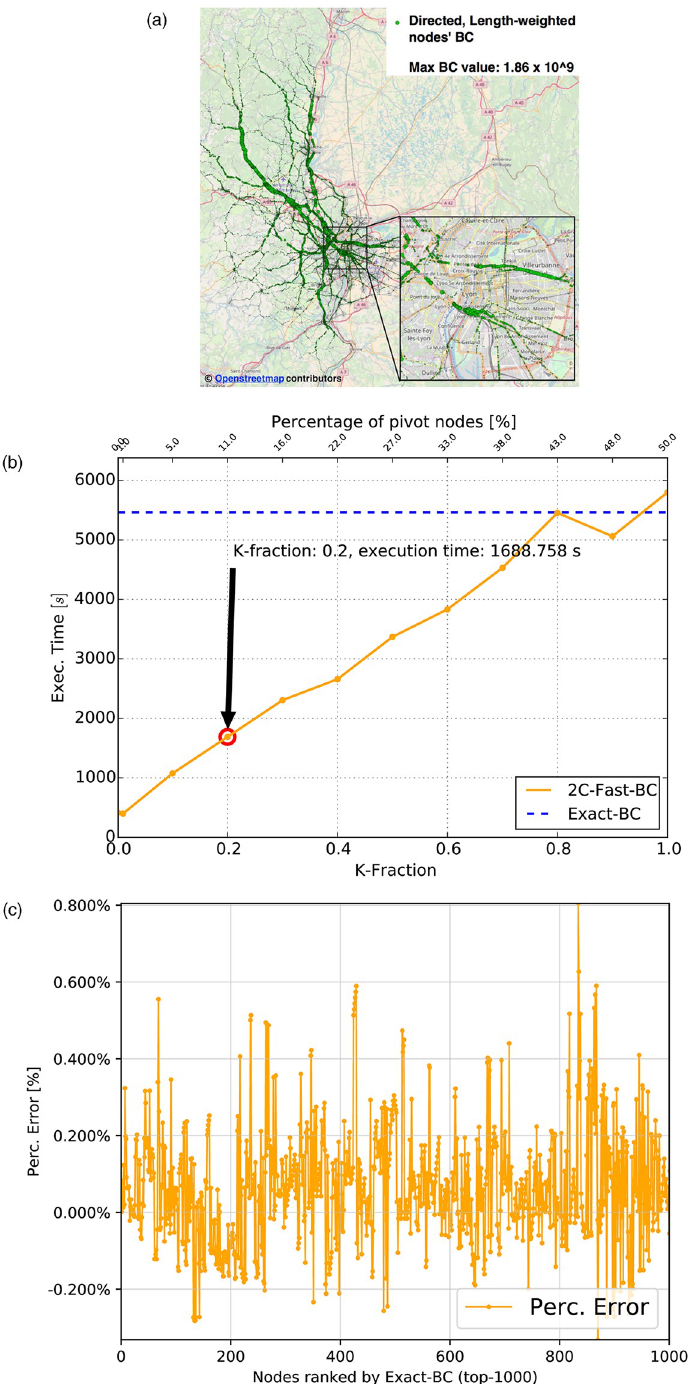
Fig 8. Directed graph weighted with discretized road-lengths. (a) Nodes’ BC values (circle size proportional to node’s BC) (b) Execution times (W2C-Fast-BC and Brandes BC) with 10 cores (c) Percentage error of W2C-Fast-BC with K-fraction = 0.2